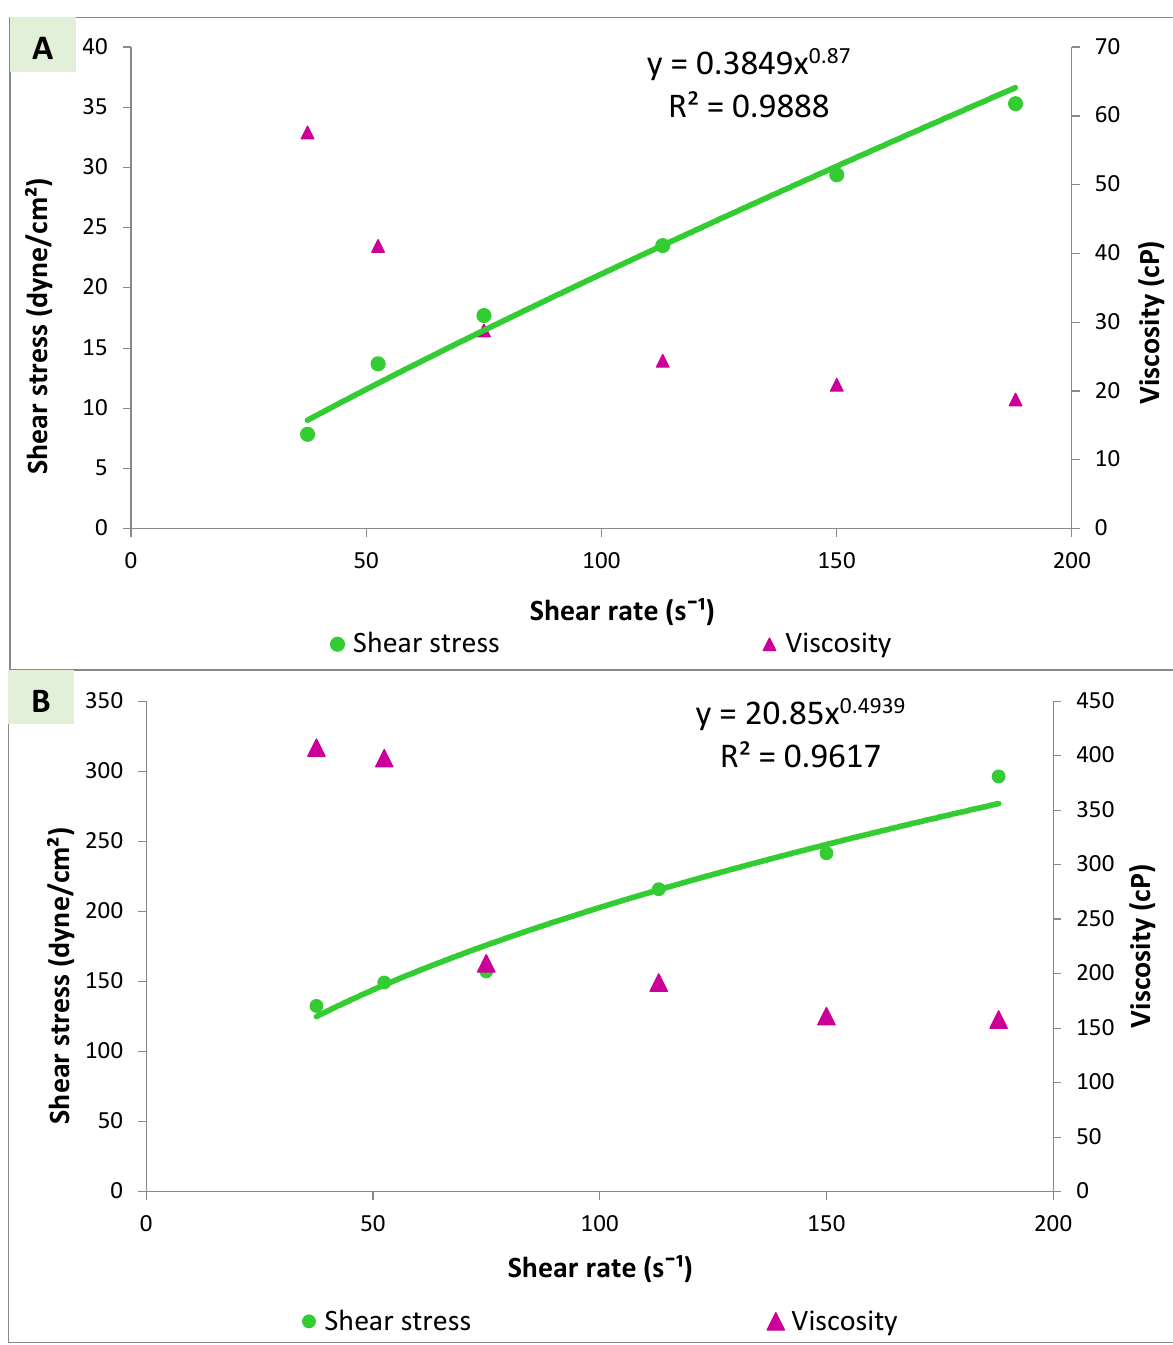
Figure 4. Rheogram of N7-gellan mixture (( A ) sol phase, ( B ) gel phase).